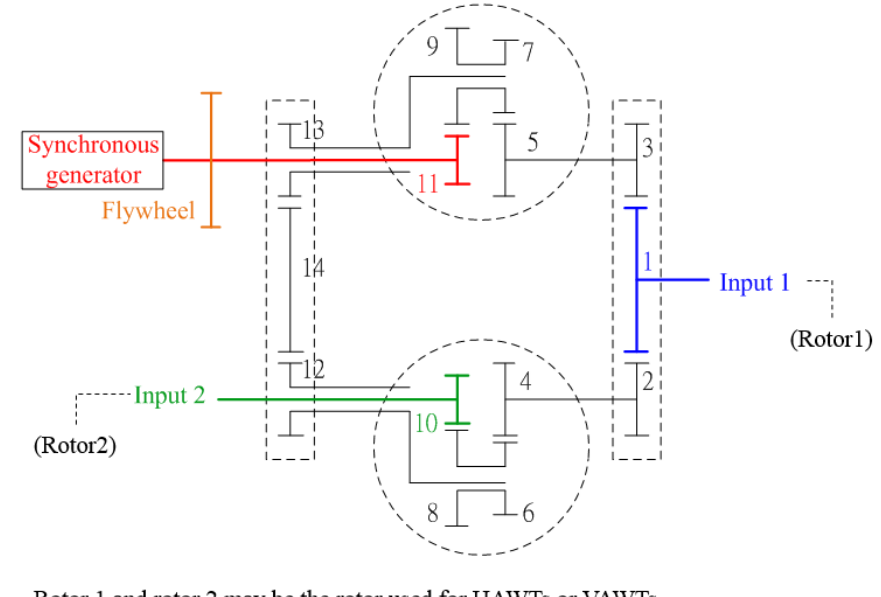
Figure 5. Dual input transmission mechanism.